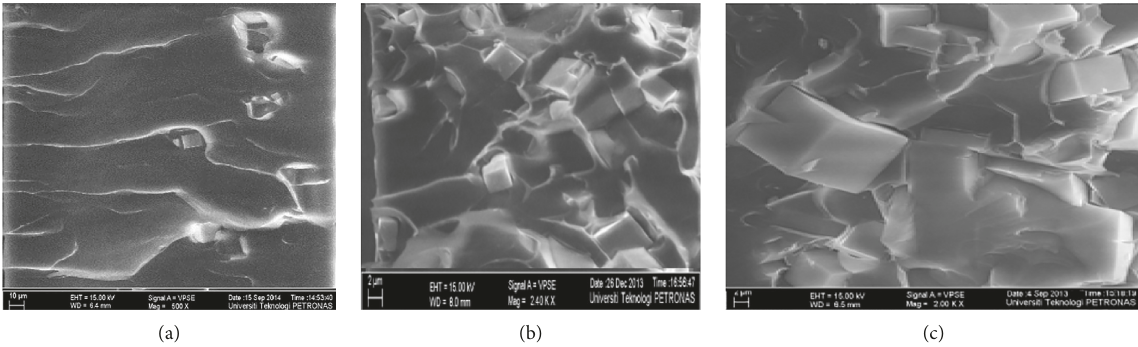
Figure 4: (a) 10w/w%, (b) 20w/w%, and (c) 30w/w% SAPO-34 loading in ionic liquid mixed matrix membranes.